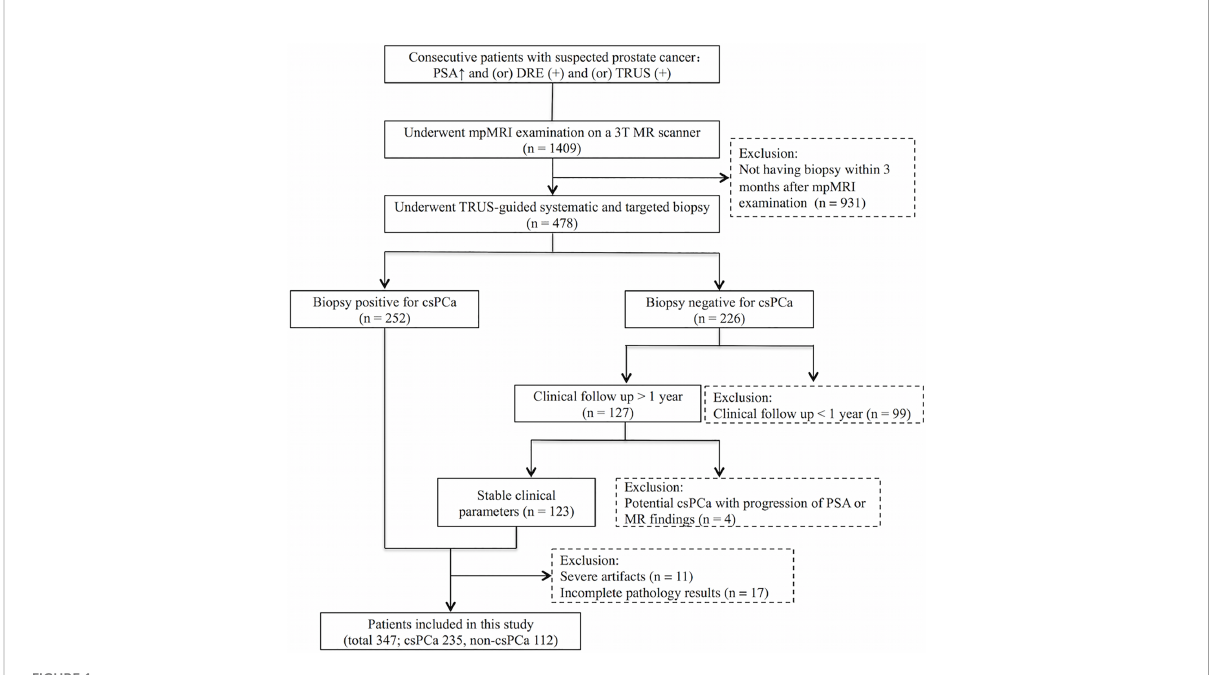
FIGURE 1 Flow diagram for inclusion of patients into the